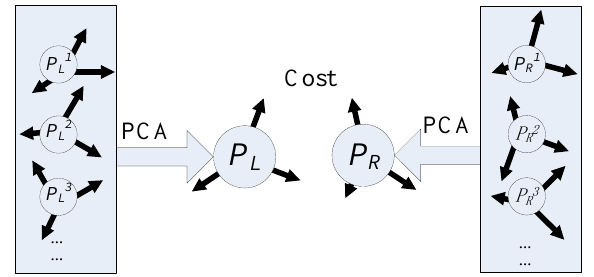
Figure 4. Calculation of the cost between left image pixel P L and right image pixel P R . Each pixel has different gradients in the direction of Z , and we use PCA to obtain the principal direction of the